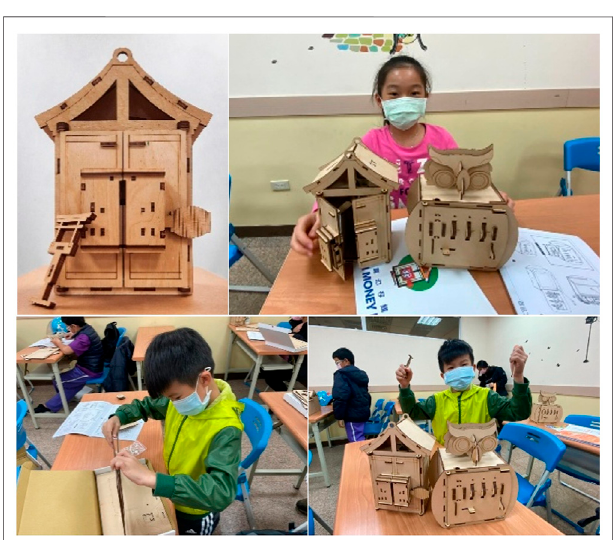
FIGURE 1 | Photos of the house-shaped money-saving tube and students participating in the study.